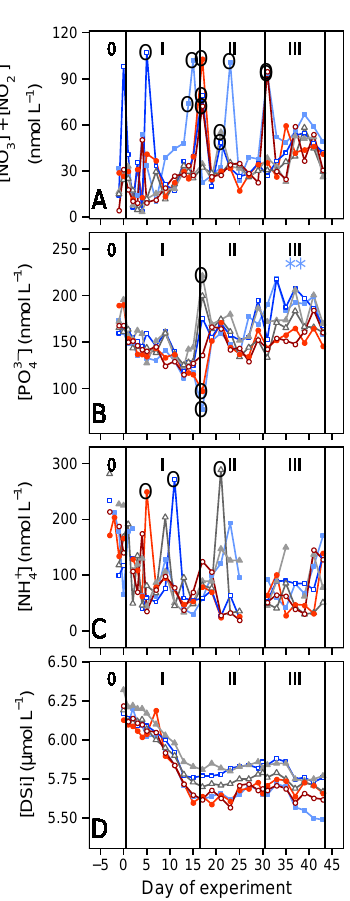
Figure 10. Temporal variation in concentrations of (a) dissolved nitrate + nitrite, (b) dissolved inorganic phosphate, (c) ammonium, and (d) dissolved silicate. Colours and symbols are described in Ta- ble 1. Blue asterisks denote a statistically significant negative effect of CO 2 (** = p <0.01). Outliers (Grubb’s test; see methods) are in- dicated by black circles and were excluded from linear regression analyses.